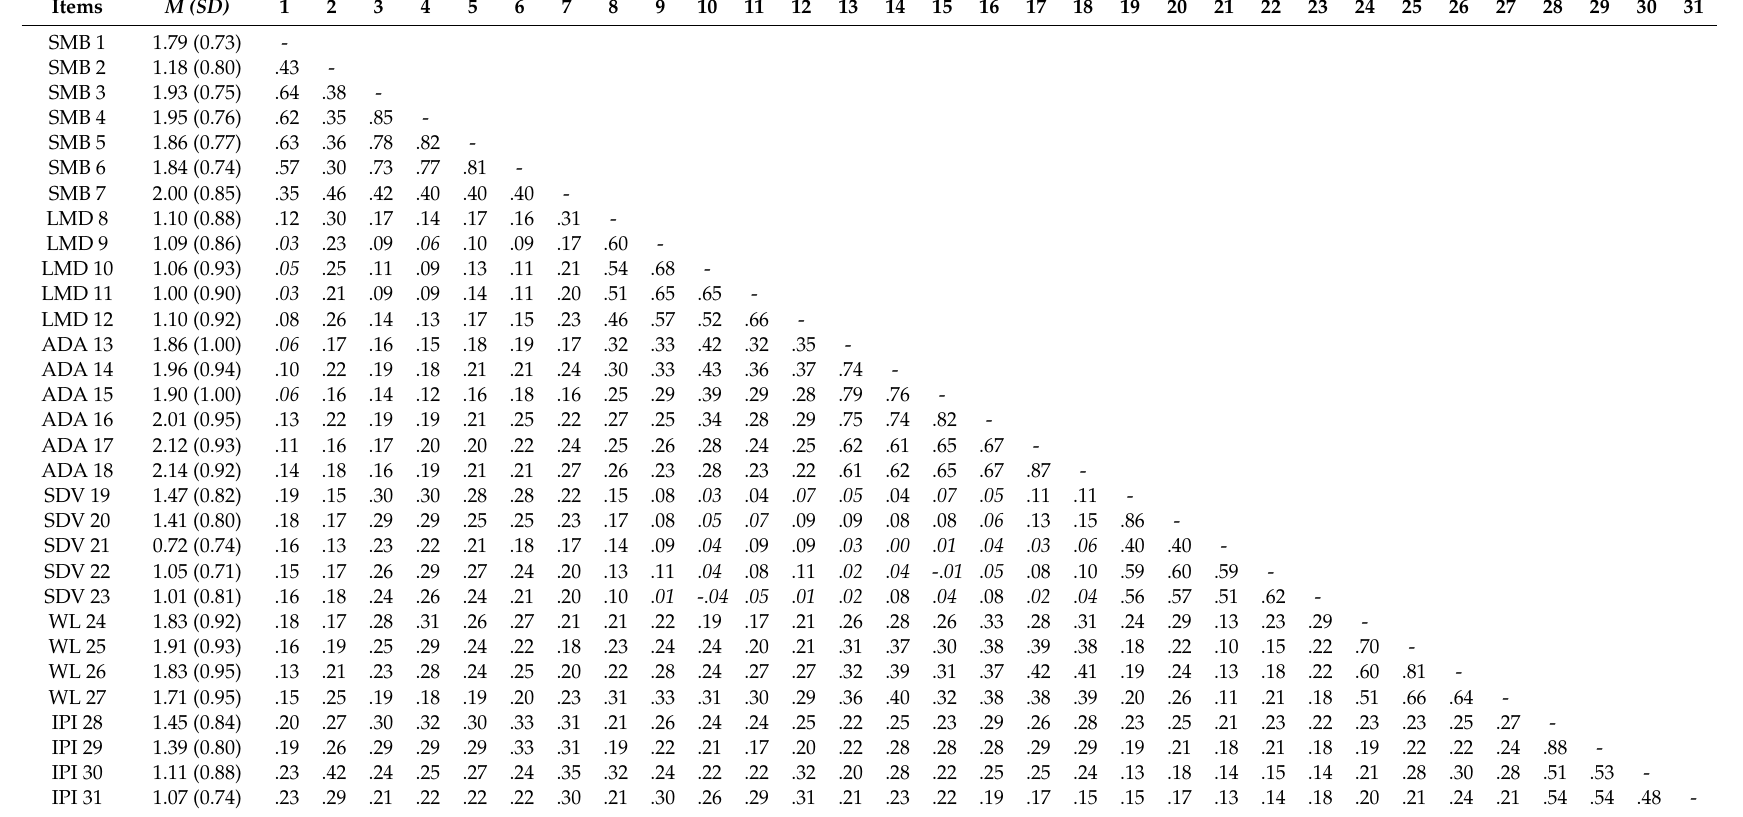
Table 1. Descriptive statistics and Pearson’s correlations for the items of the Multicontext Stressors